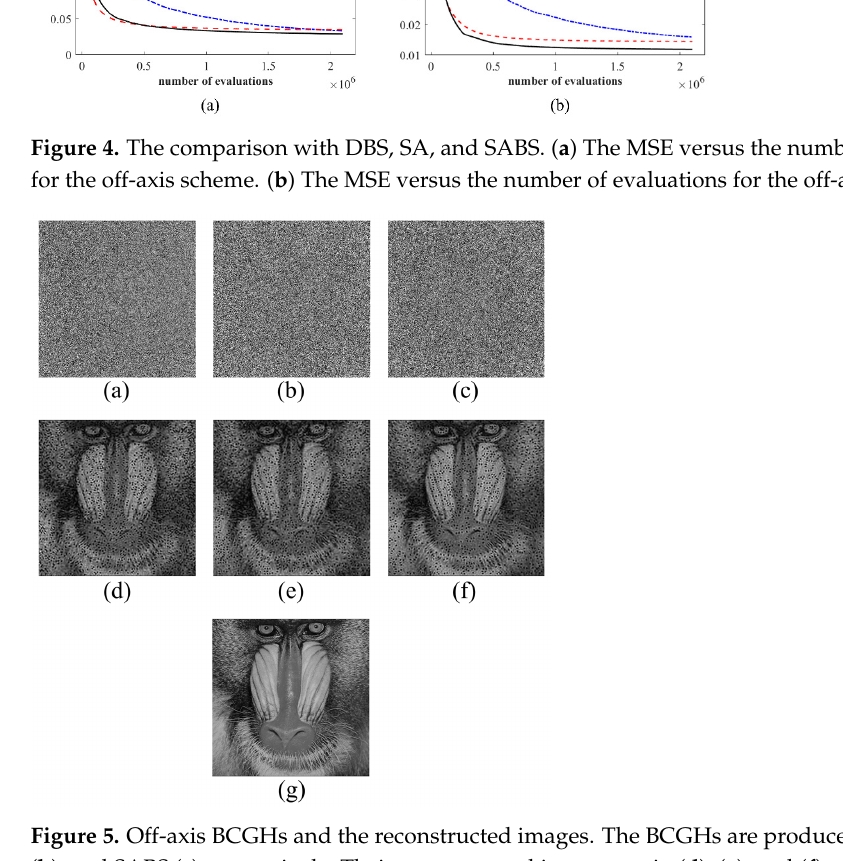
Figure 6. On-axis BCGHs and the reconstructed images. The BCGHs are produced by DBS ( a ), SA ( b ), and SABS ( c ), respectively. Their reconstructed images are in ( d ), ( e ), and ( f ), respectively.